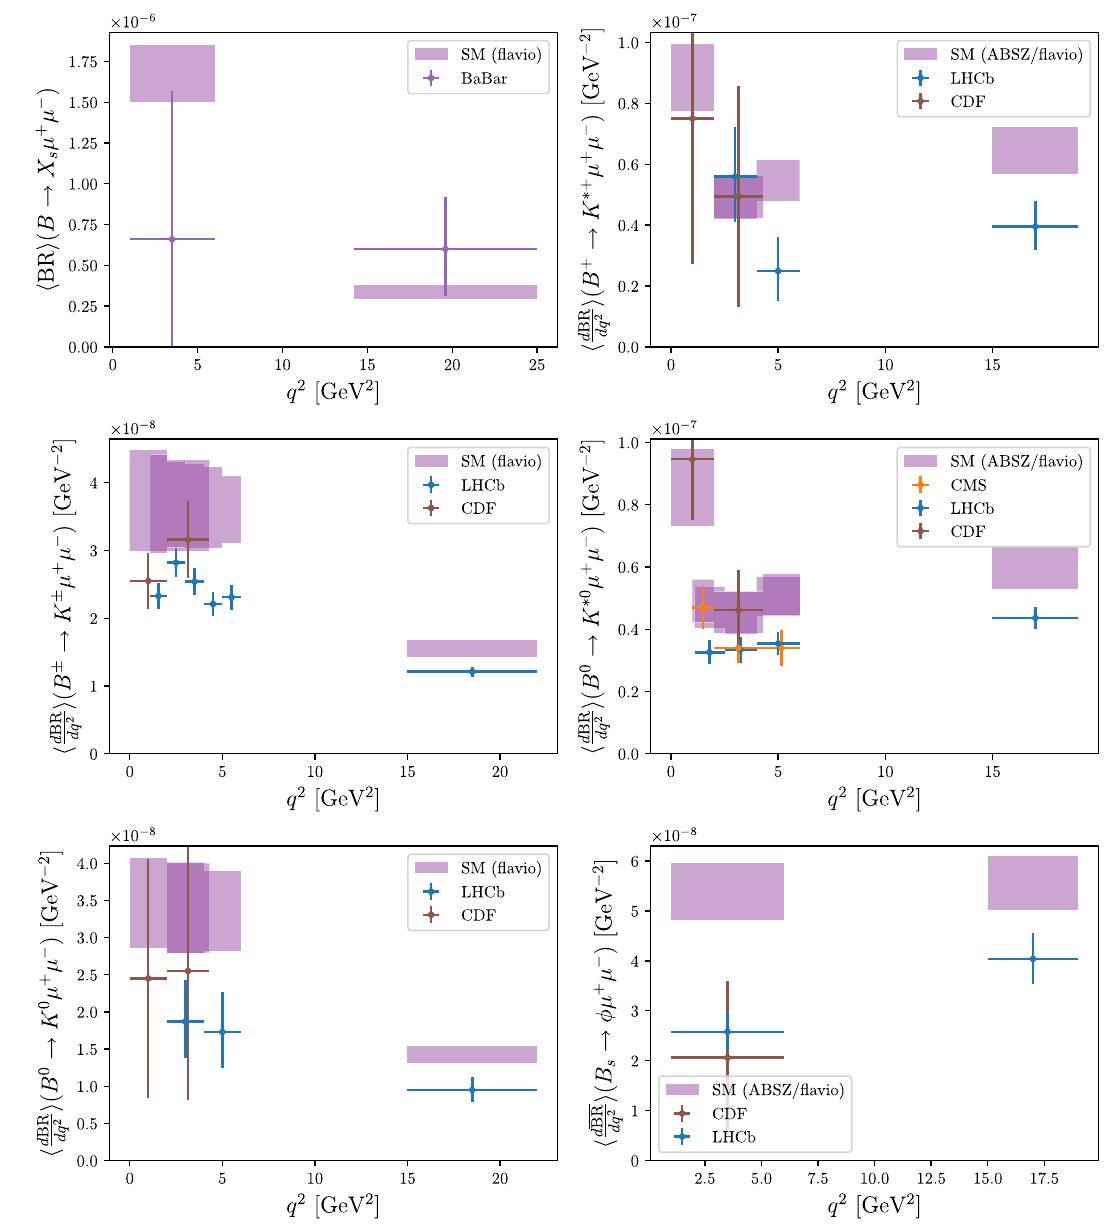
Fig. 5 Experimental measurements vs. SM predictions for the branching ratios. “ABSZ” refers to [20,32]